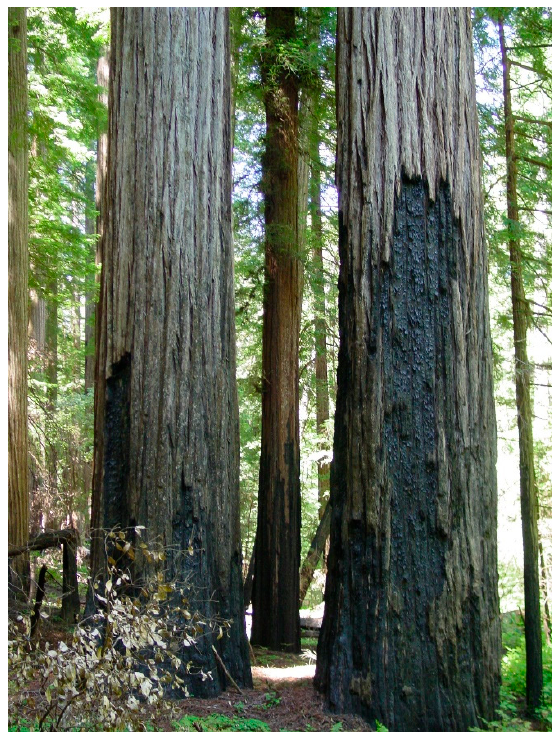
Figure 4. Bark of old redwood trees partially consumed by wildfire.